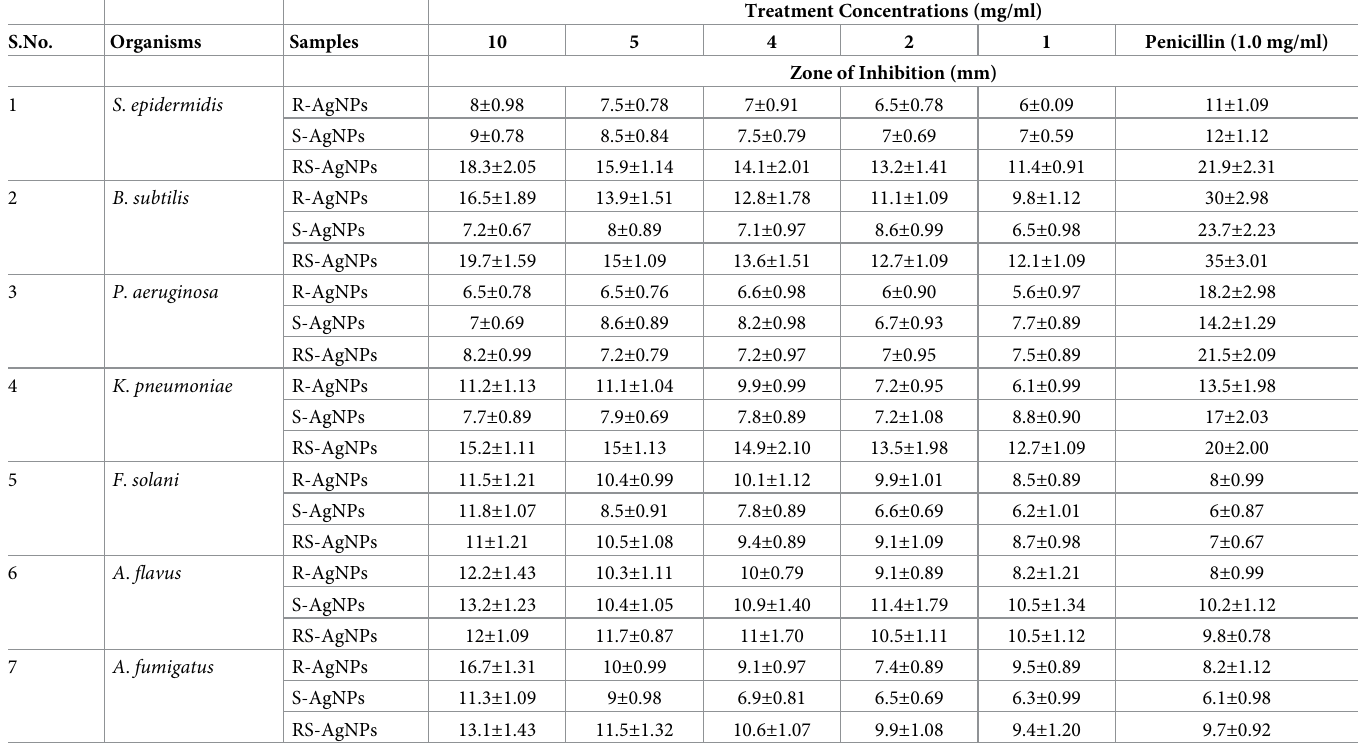
Table 3. Results of the antibacterial potentials of R-AgNPs, S-AgNPs and RS-AgNPs against pathogenic strains.